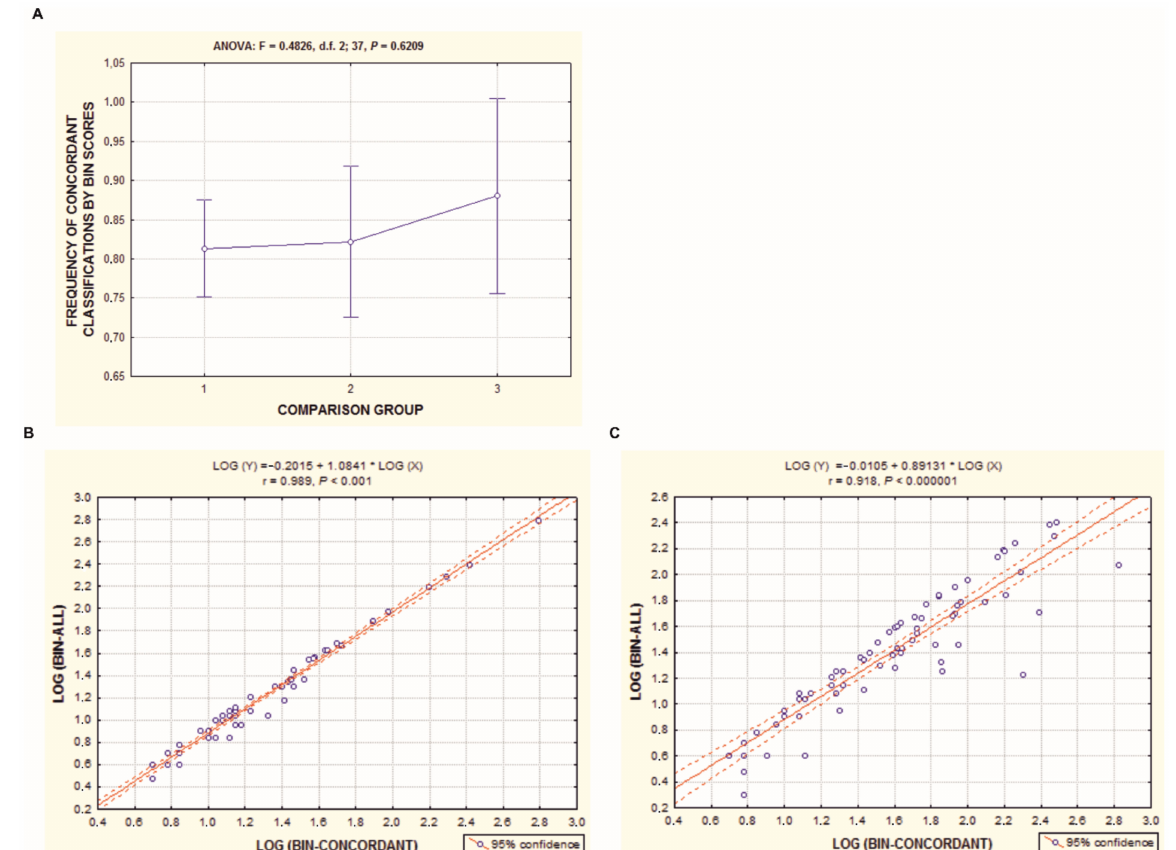
Figure 4. ( A ) ANOVA of BIN score distribution in three fish taxa analyses that were retrieved from BOLD. BIN, barcode index number showing the frequency of concordant classifications (%, Y − axis) of a tested species-specimen by Co-1 mtDNA barcode records and its correspondence to the entire set of records in the BOLD data base that was named in an independent way. The comparison groups (X − axis) are specimens assigned to the certain species (1), genus (2), or family (3). Frequencies of concordant classifications do not differ among the analyzed research projects (see for details [28]); the same also applies to the three comparison groups in the plot (top). The overall average of concordant classifications by BIN estimates is over 82%. ( B , C ) Regression analysis of covariation of two variables in the BOLD projects of fish. LOG (BIN-ALL) values (a variable that designates zoologically identified specimens for intraspecies, intragenic, and intrafamily categories as recorded in BOLD, Y − axis) plotted against LOG (BIN-CONCRDANT) scores (all concordant OTU-clusters for Co − 1 mtDNA barcode records or sequence-specimens for the same three categories, X − axis). Variations show a statistically significant positive linear dependence of the two variables for combined projects FERU/TZFPC ( B ) and SCFAA project ( C ). The overall covariation of the two variables for the data set, as estimated by the coefficient of determination on BIN scores, is R 2 = 98% and R 2 = 84%, respectively, for two analyses. More details of the analysis are provided elsewhere